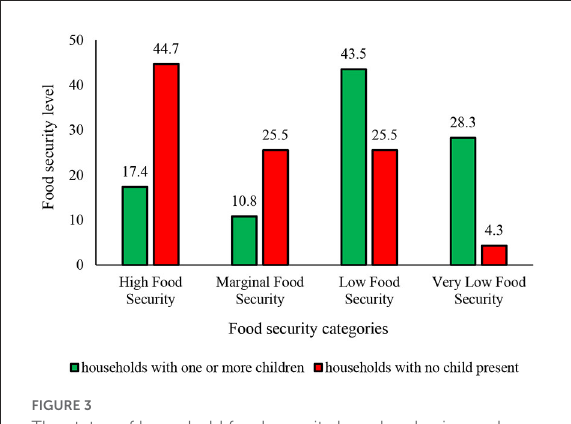
TABLE 5 The status of children’s food security.